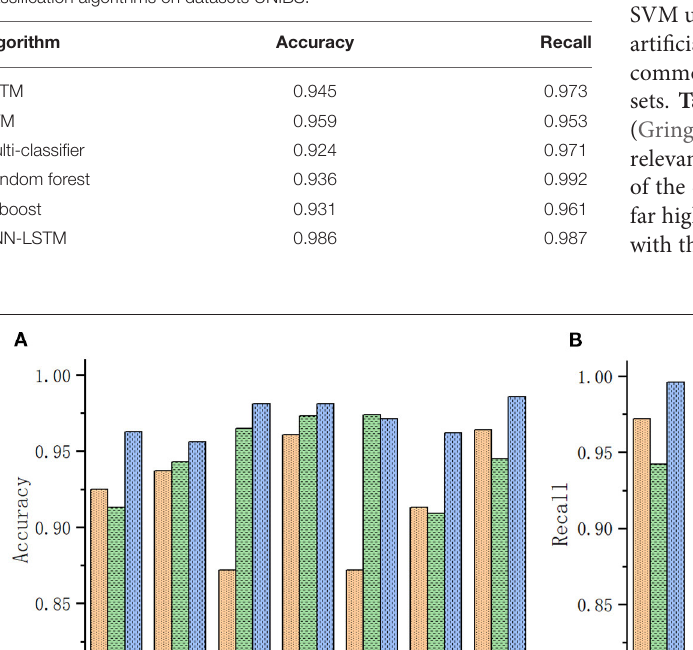
TABLE 6 | Comparison of classification performance with other traffic classification algorithms on datasets UNIBS.